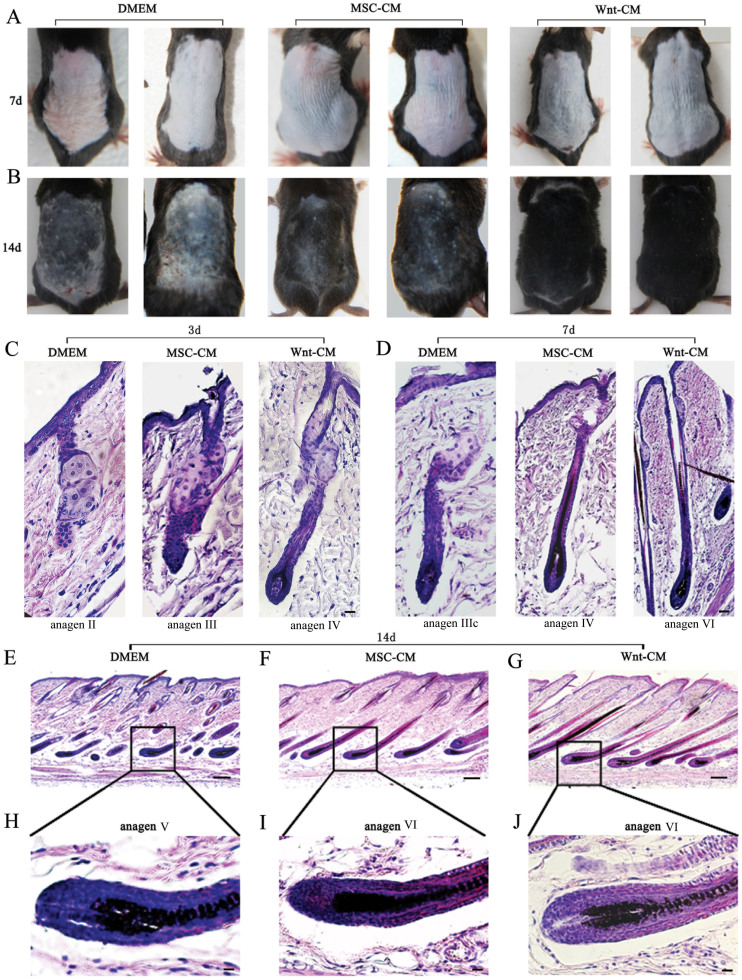
Wnt-CM promotes the hair follicle cycle in mice.Telogen C57BL/6 mice were intradermally injected with Wnt-CM. Typical photos of dorsal skin reveal that the stage of the hair cycle by observed comparison of dorsal skin colors and hair growth (A, B). HE staining indicates a structural change of hair follicles (C–J). (E), (F), (G) represent different stages in the hair cycles at 14 days by HE stained. (H), (I), (J) show a magnification of the framed labeled area. Scale bar (E–G) = 50 μm, (C), (D), (H–J) = 20 μm.